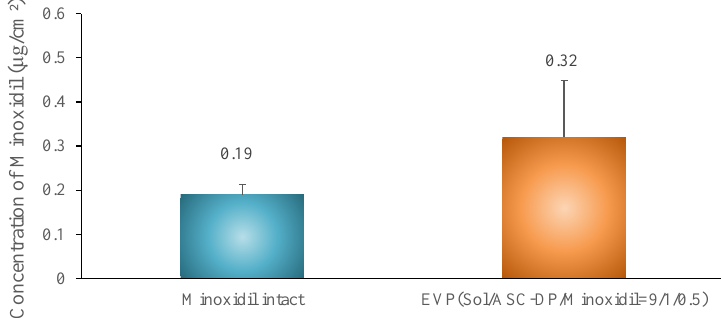
Figure 13. Cumulative amount of transdermal minoxidil after 24